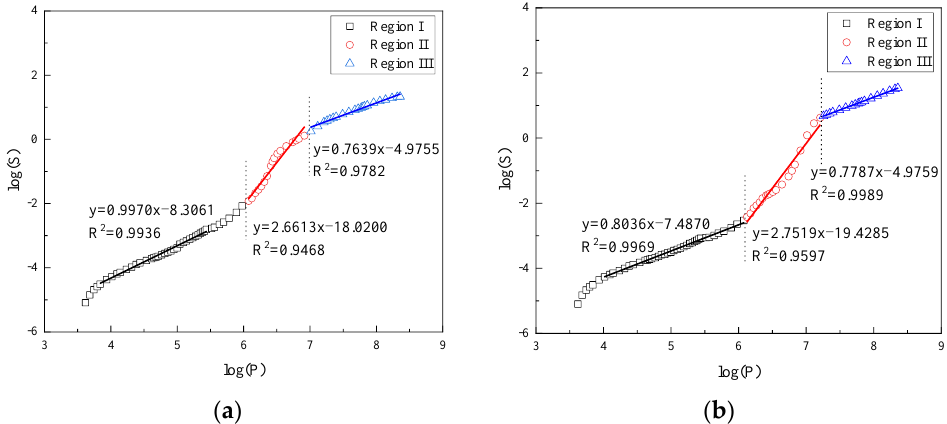
Figure 6. Multifractal characteristics of FCP30 at different ages under Neimark’s model. ( a ) 3 days, ( b ) 28 days.